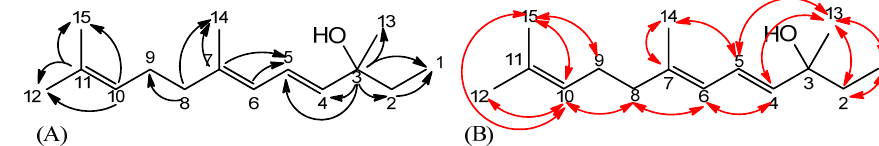
Figure 2. Long range 13 C- 1 H HMBC ( A ) and NOE ( B ) correlations of 58 .